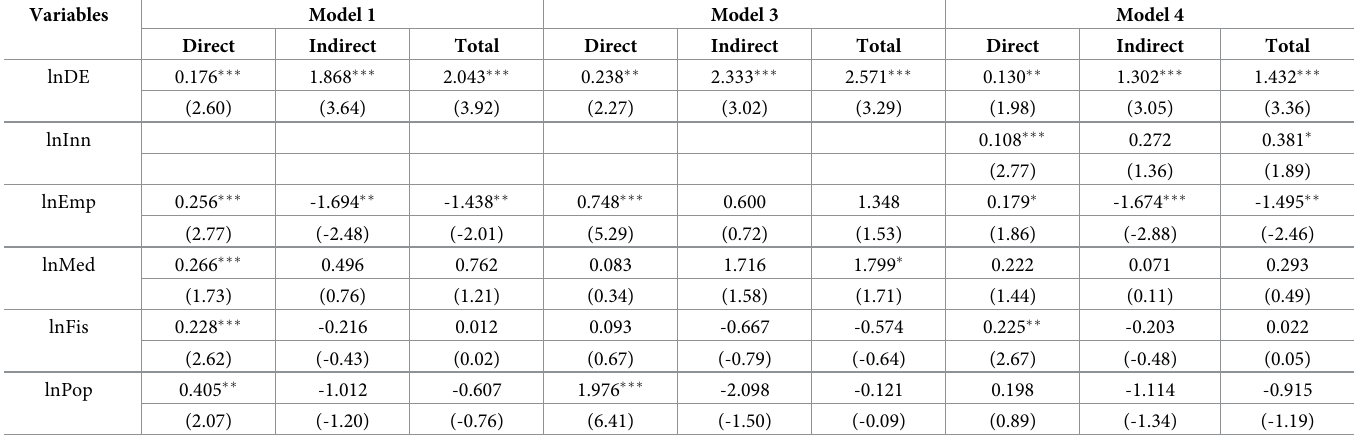
Table 8. Regression results of direct, indirect and total effects.